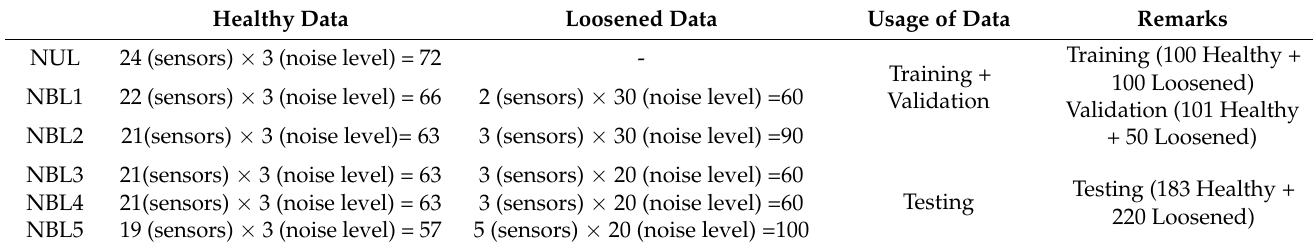
Table 8. Arrangement of the numerical synthetic data for training, validation, and